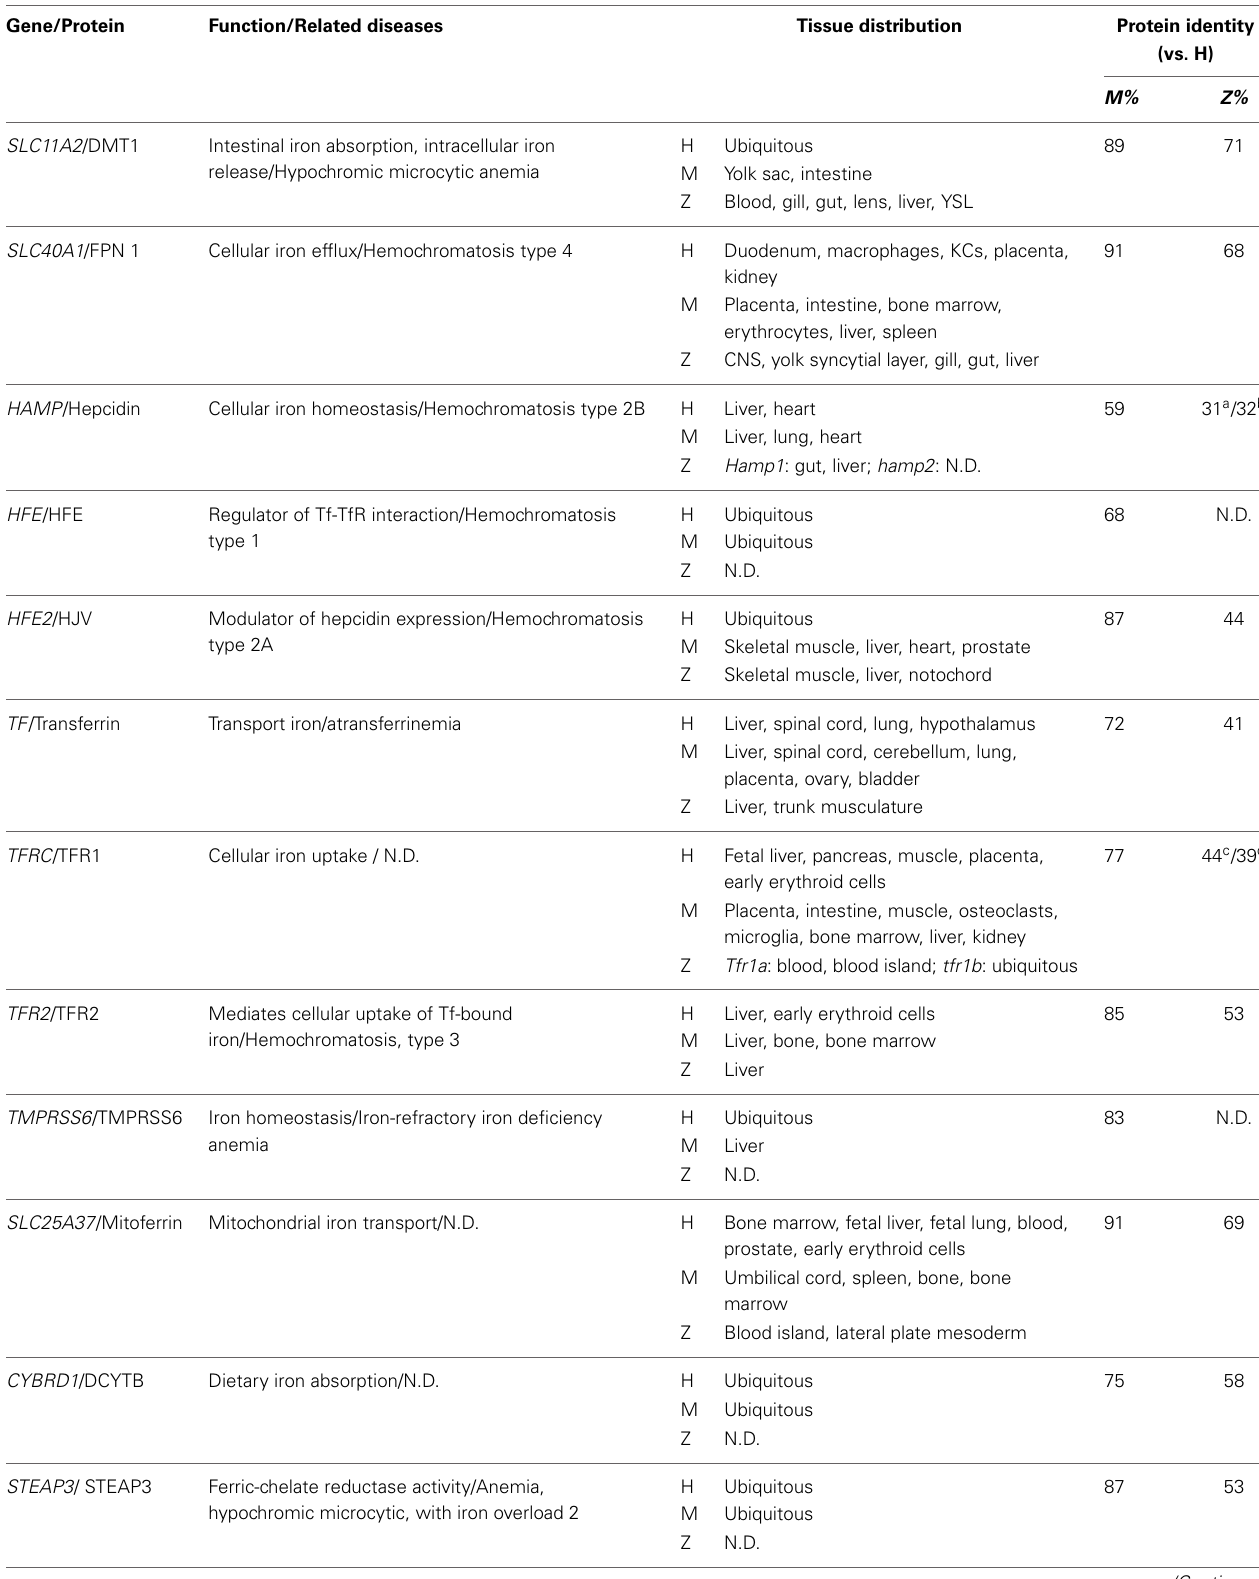
Table 1 | Iron metabolism–related proteins in zebrafish, mice, and humans. Gene/Protein Function/Related diseases Tissue